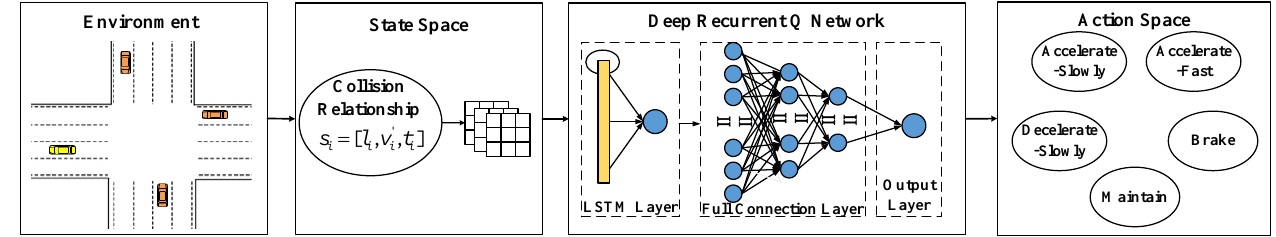
Figure 3. Construction of Driving Behavior Decision-making Method based on CR-DRQN.